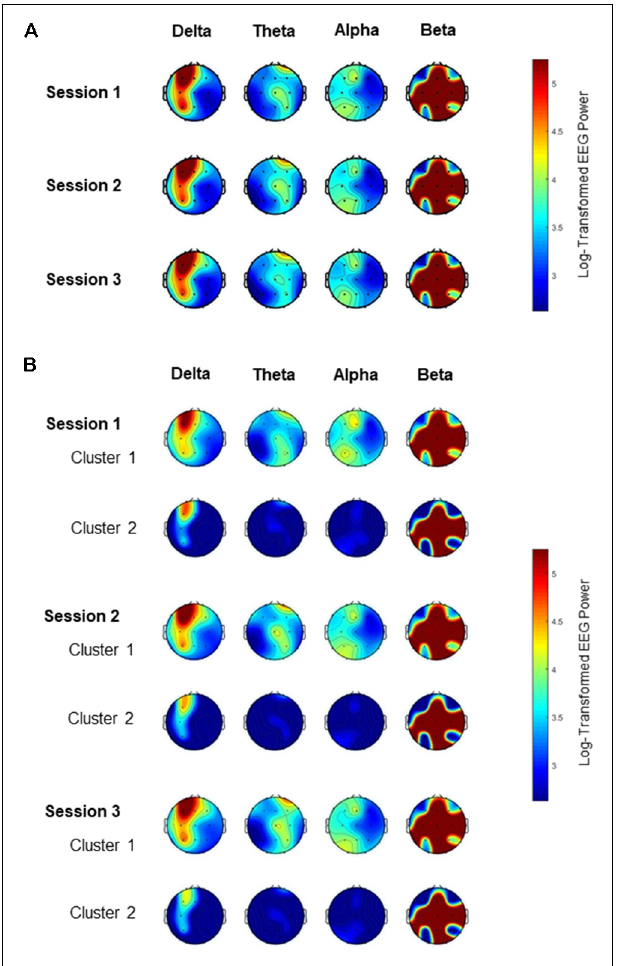
FIGURE 1 | Topography of electroencephalogram (EEG) power for the four frequency bands among the three EEG sessions. The color spectrum corresponds to the log-transformed EEG power for the delta ( < 4 Hz), theta (4–8 Hz), alpha (8–13 Hz) and beta (13–40 Hz) band. (A) EEG band powers are consistent across all three sessions. (B) EEG band powers are different between the two clusters in each of the three sessions, especially for the delta frequency